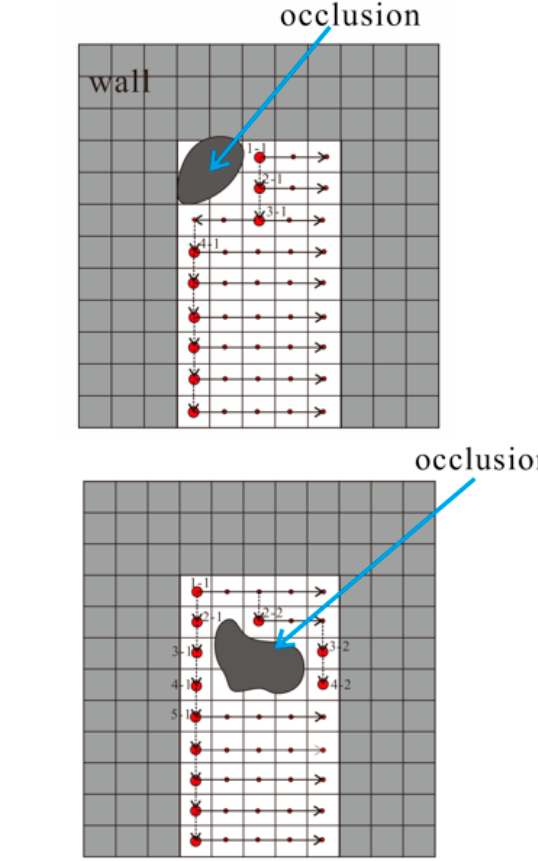
Figure 9. Four examples for U-V direction region growing.